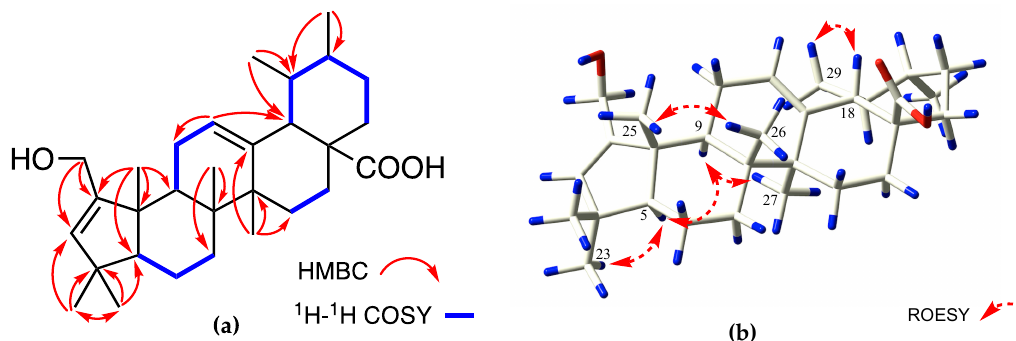
Figure 4. ( a ) Key 1 H- 1 H COSY and HMBC correlations of 2 . ( b ) Selected ROESY correlations of 2 .